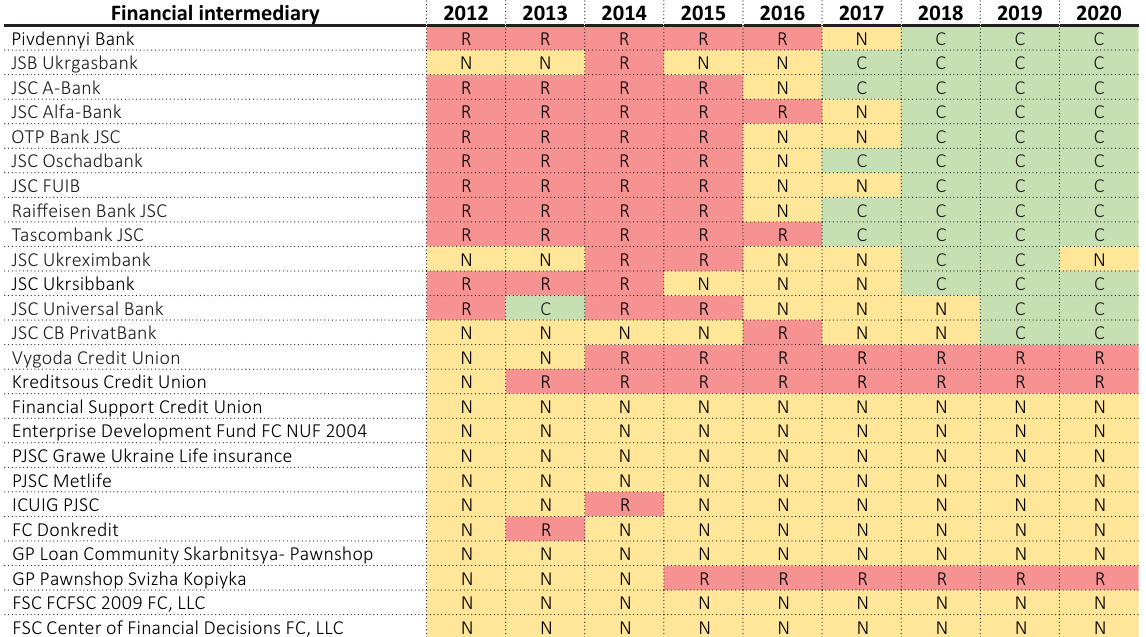
Table 16. A set of development patterns of financial intermediaries’ trajectories according to the probability of participation in shadow